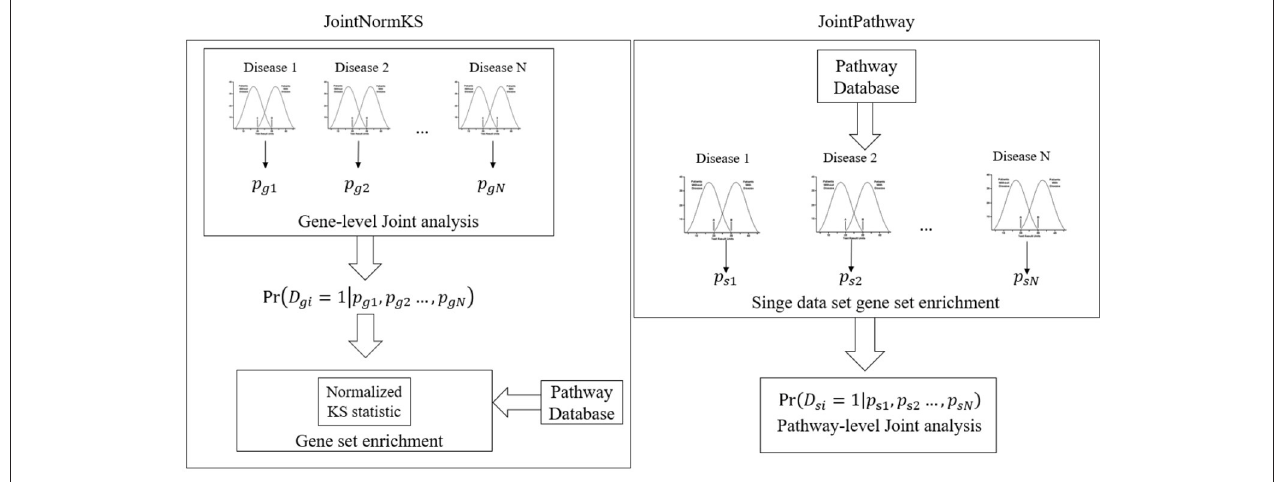
FIGURE 1 | Overview of the proposed joint gene set enrichment frameworks.